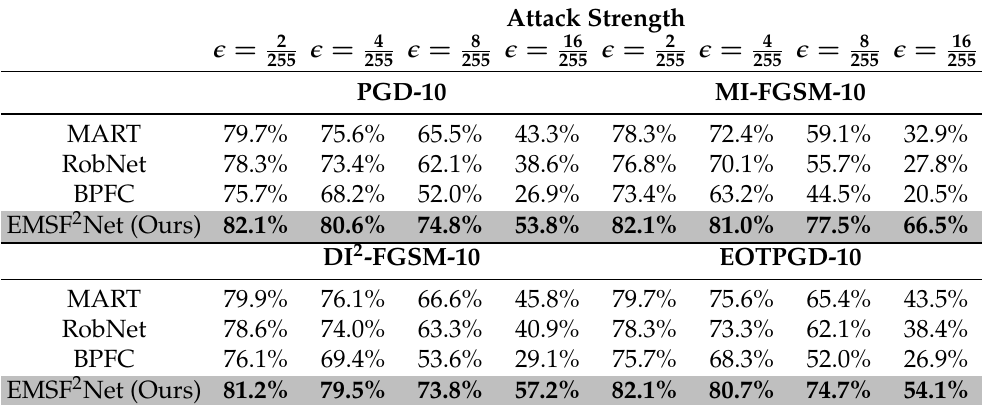
Table 3. Robust accuracy against L ∞ -norm attacks with less complexity on CIFAR-10 dataset. The lightgray row represents the results of the proposed method, and the bold results represent the best